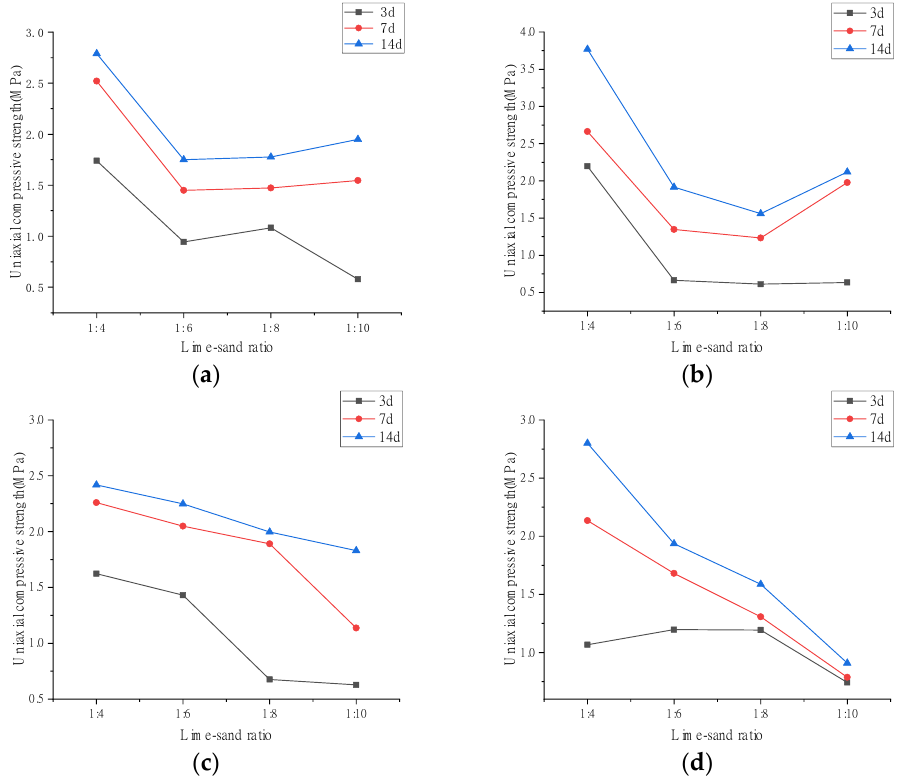
Figure 10. Uniaxial compressive strength at different concentrations of lime – sand ratio ( a ) When the lime – sand ratio concentration is 62%, ( b ) When the lime – sand ratio concentration is 64%, ( c ) When the lime – sand ratio concentration is 66% and ( d ) When the lime – sand ratio concentration is 68%. Under different backfilling processes, the backfilling body plays different roles in the recovery process, so the requirements for strength are also different. According to the ac- tual index and production experience of the gold mine, the 7 d strength value of the ex- perimental specimen is selected as the selection index; the proportion concentration of 1:6 and 66% in the medium and fine tailings cemented specimen meets the strength require- ments of the surface layer of the backfilling body. Figure 11 is the state of the paste-back- filling slurry.